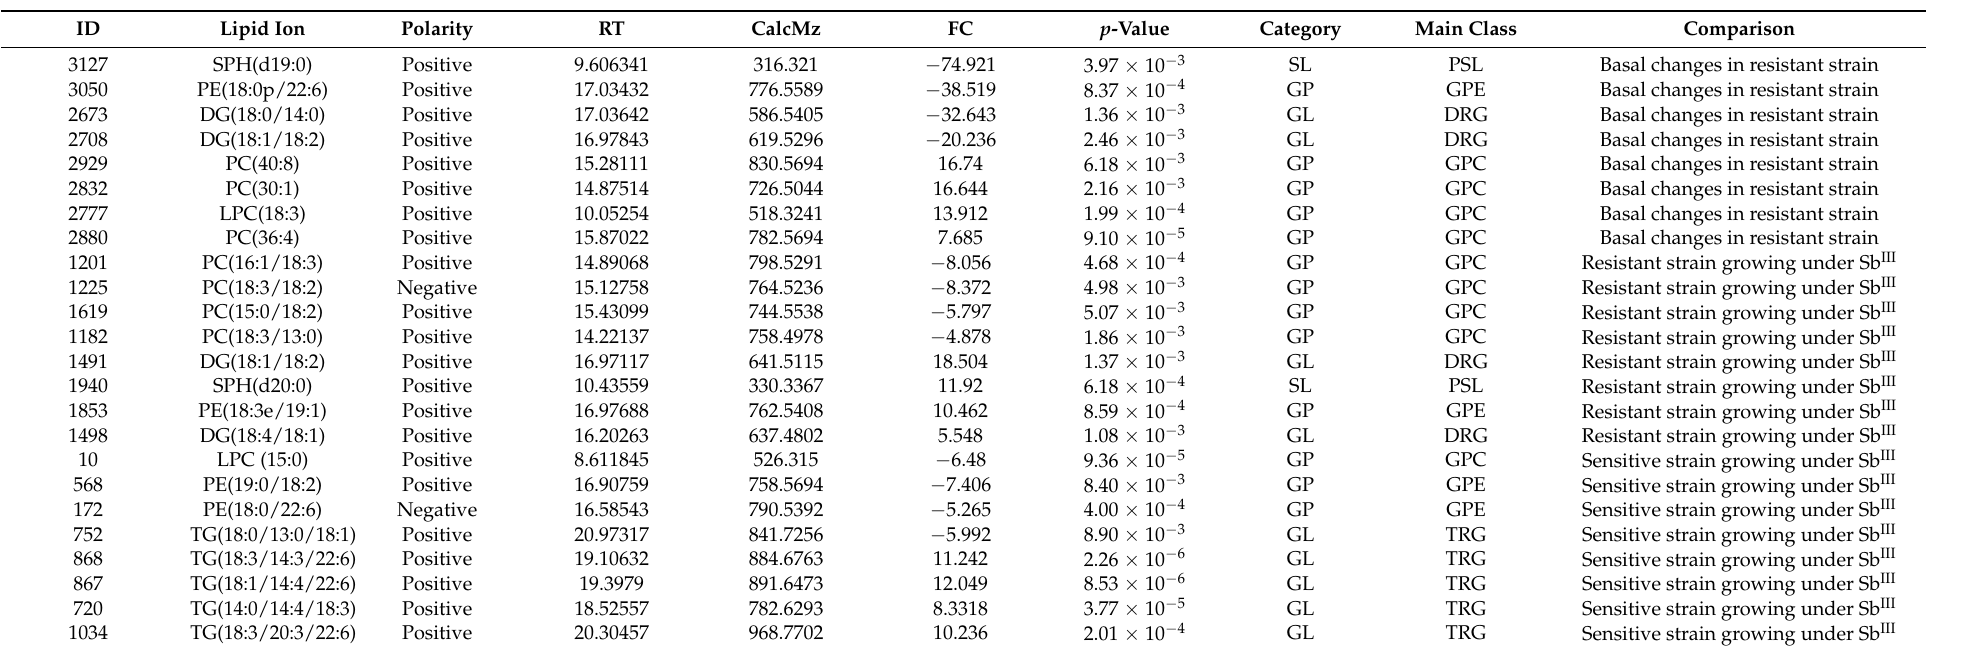
Table 1. List of potential lipid biomarkers for the differentiation of antimony resistant phenotypes in Leishmania